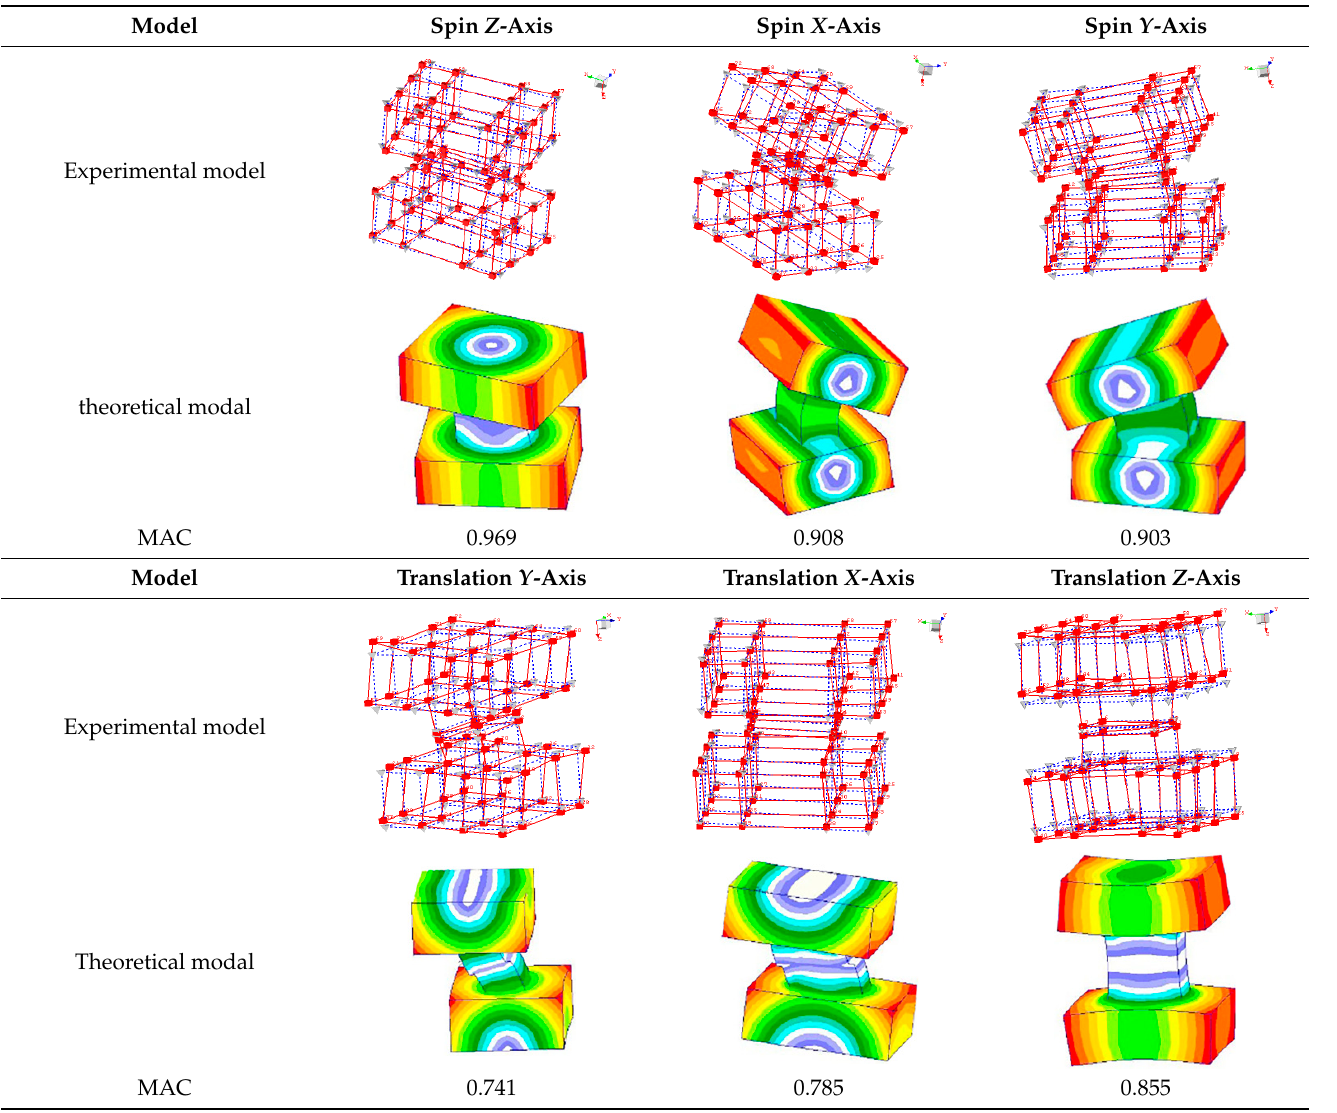
Table 8. Comparison of the theoretical modes and experimental modes.